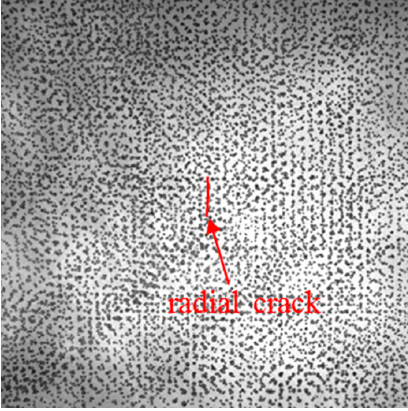
Figure 8. Initial pattern of cracks on the free surface in case of uniaxial compression load.